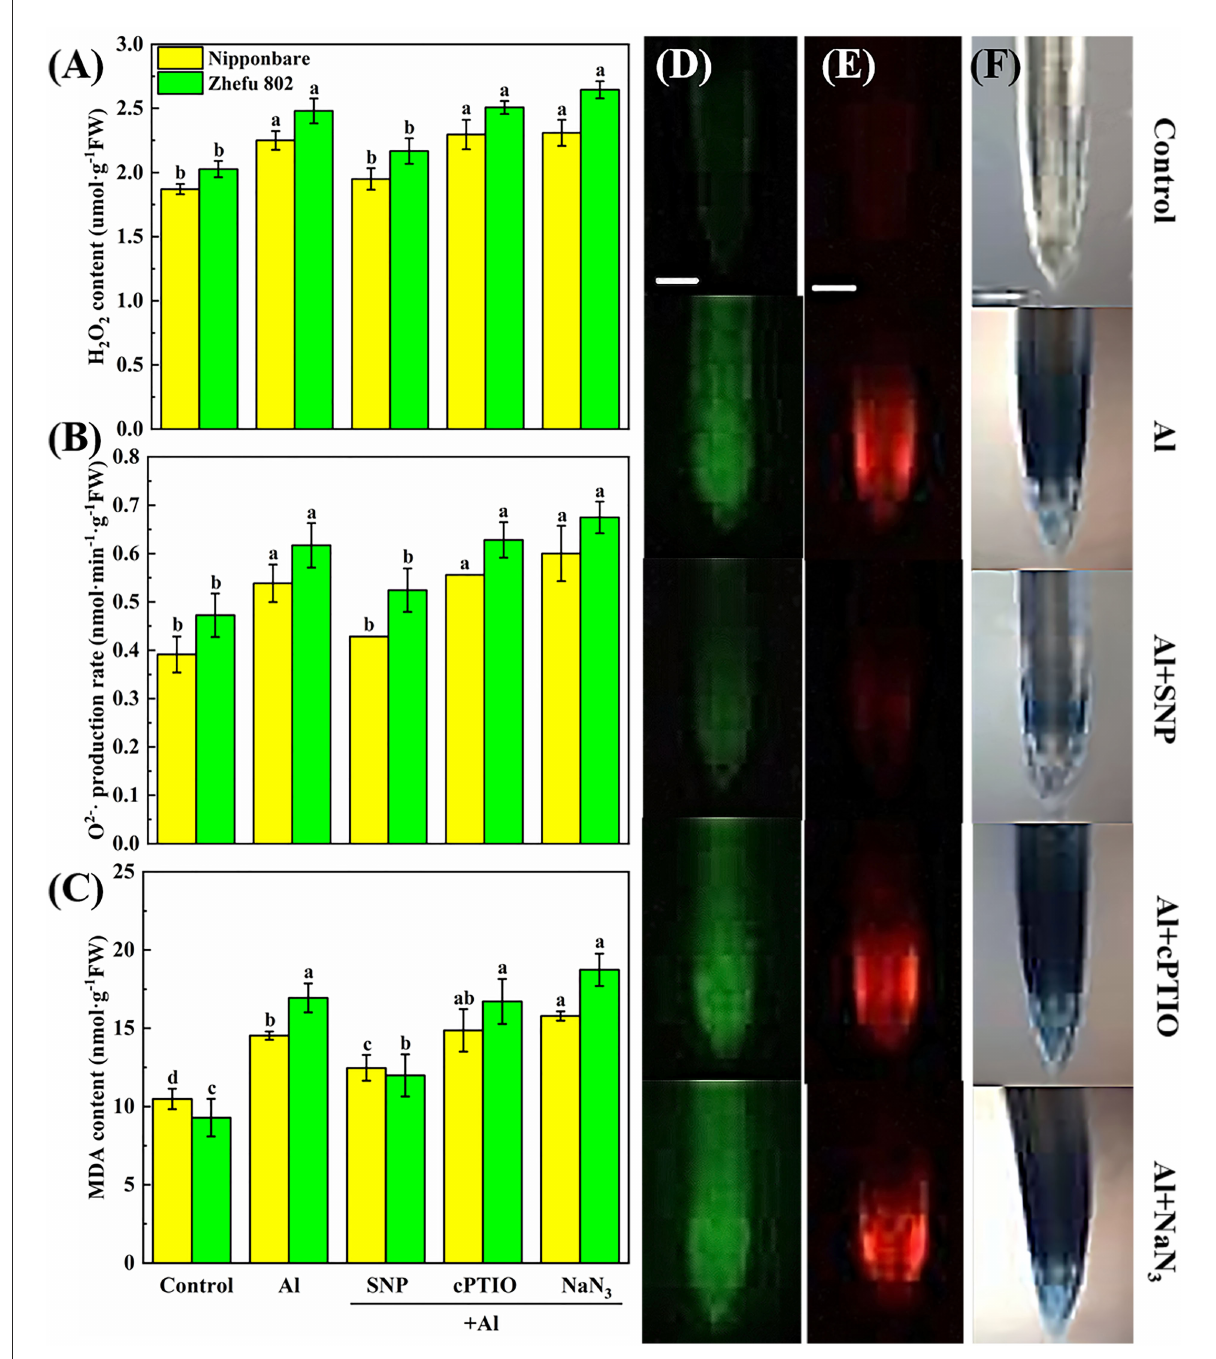
FIGURE2 The effect of SNP and NO scavengers on (A) H 2 O 2 , (B) O 2 − · production rate, and (C) MDA in rice root tips under Al toxicity and (D) H 2 O 2 , (E) O 2 − , and (F) oxidative damage in situ observation in root tips. Columns with different letters are significantly different at P < 0.05 . Bar in graph (D–F) indicated 200 µ